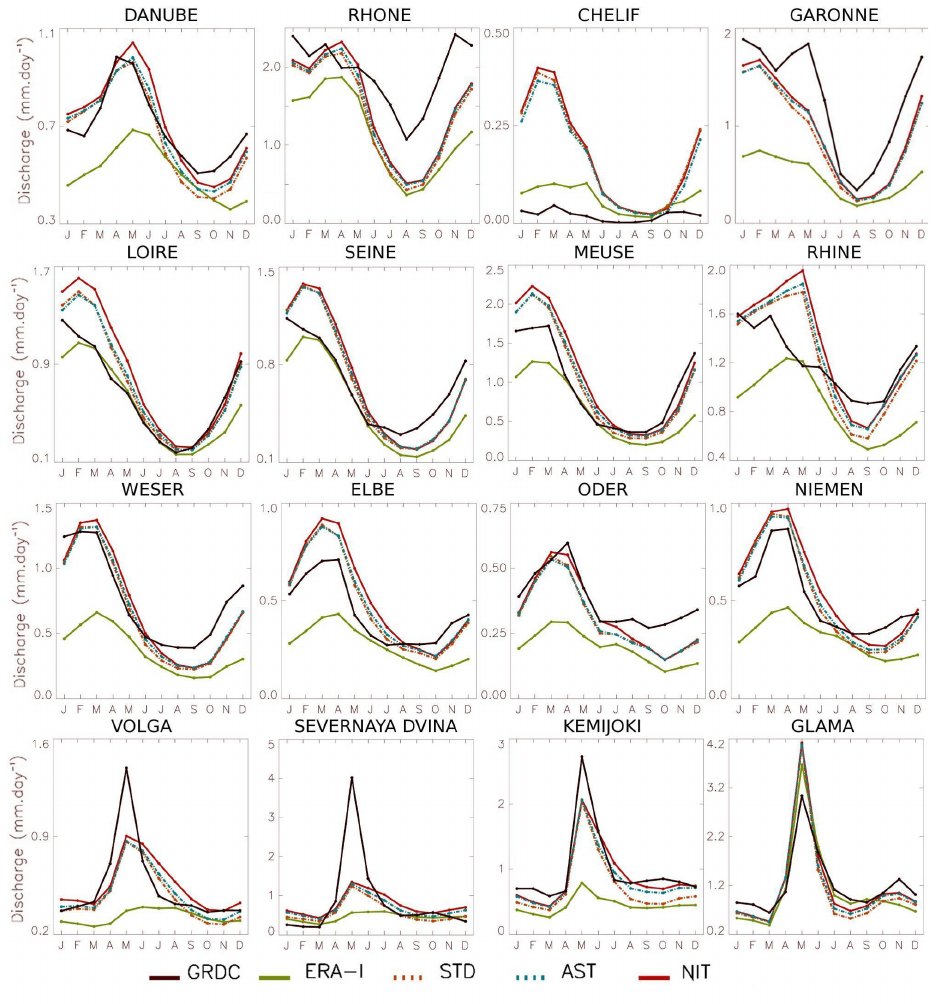
Fig. 7. Comparison of the mean river discharge annual cycles, (coloured lines) simulated and (dark lines) observed (GRDC) at the outlets of the main rivers of the CNF area (red dots in Fig. 1) over the 1991–2008 period. The NIT and ERA-I simulations correspond to NIT-TRIP driven by ERA-I-RG and ERA-I, respectively. The STD and AST simulations correspond to STD-TRIP and AST-TRIP driven by ERA-I-RG,